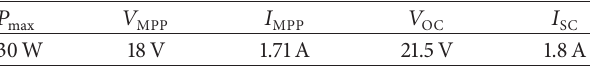
Figure 6: System structure. Table 1: Specification of KYOCER KC30 solar panel.